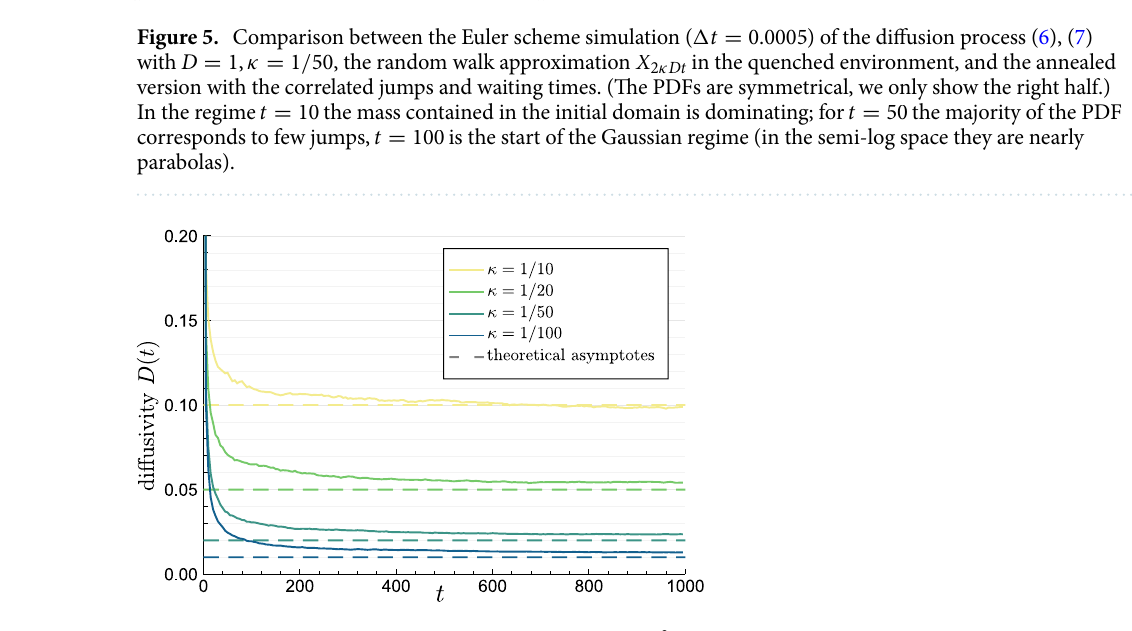
δ 2 ( t )/( 2 t ) calculated from the numerical simulation X := 1 and 1 . For various permeabilities κ L k = � � = 1 and decays, reaching the level close to the value of theoretical prediction =